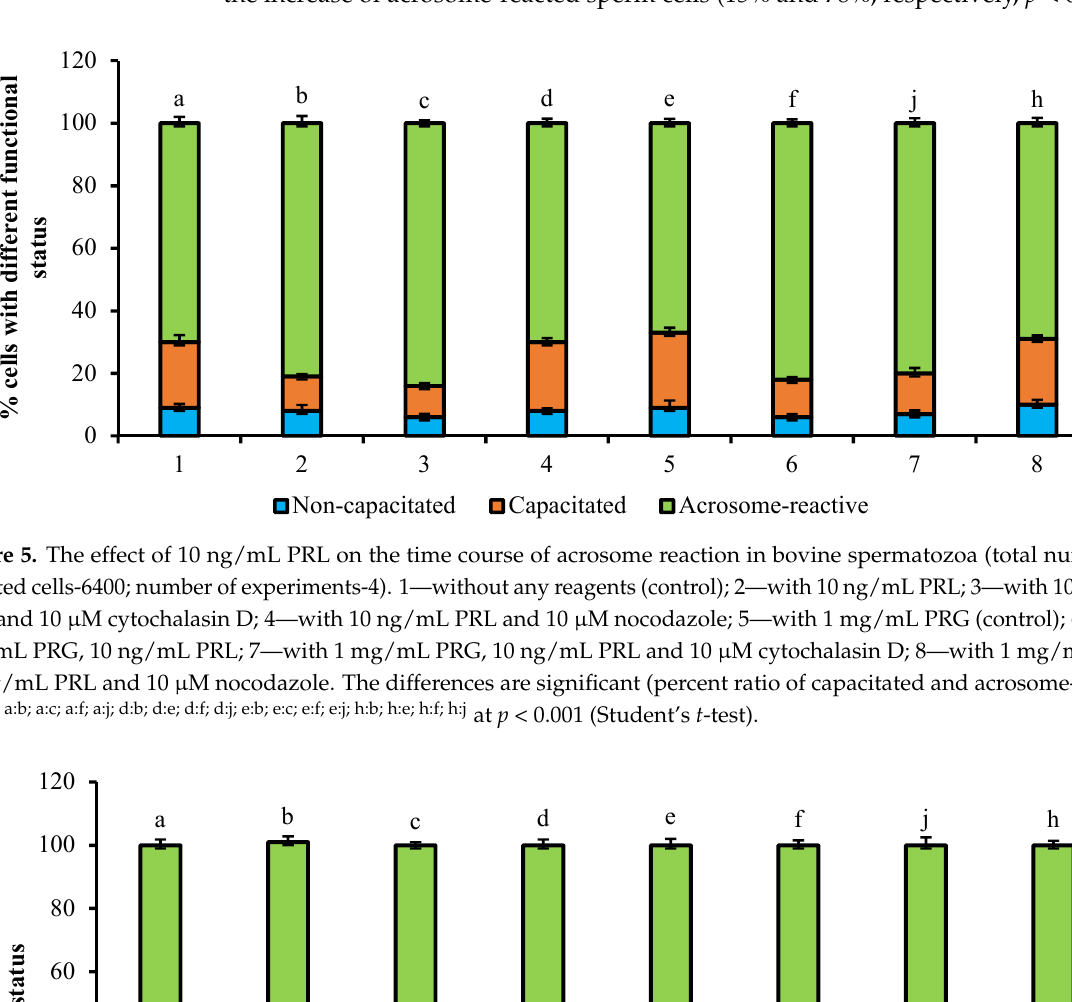
7 of 12 Figure 4. The effect of PRL (10 ng/mL) on appearance of bovine spermatozoa with different fluorescence patterns (total number of counted cells-6400; number of experiments–4). 1–without any reagents (control); 2–with 10 ng/mL PRL; 3–with 10 ng/mL PRL and 10 µM cytochalasin D; 4–with 10 ng/mL PRL and 10 µM nocodazole; 5–with 1 mg/mL PRG (control); 6–with 1 mg/mL PRG, 10 ng/mL PRL; 7–with 1 mg/mL PRG, 10 ng/mL PRL and 10 µM cytochalasin D; 8–with 1 mg/mL PRG, 10 ng/mL PRL and 10 µM nocodazole. The differences are significant (percent ratio of capacitated and acrosome- reacted cells) a:c; a:b; c:d; a:f; a:j; b:c; b:f; b:j; d:c; d:f; d:j; h:f; h:j at p < 0.001; d:e; a:e; a:h; b:e; b:h; d:h at p < 0.01 (Student’s t -test). 3.2. The Effect of PRG on Functional Status of Bull Spermatozoa during Acrosome Reaction The effect of 10 ng/mL PRL on the time course of acrosome reaction in bovine sper-